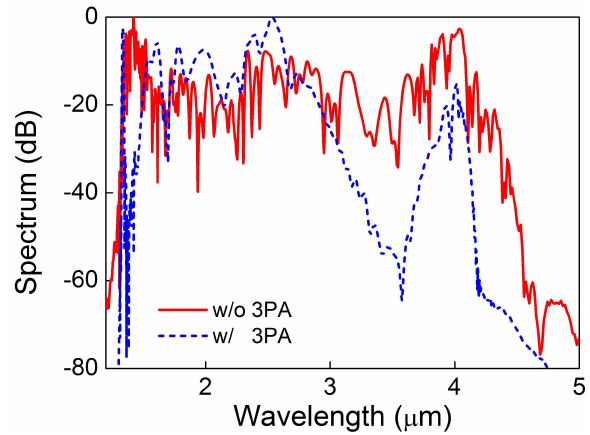
Figure 15: The spectral profiles of a single-pulse after propagation inside the 1 cm long SOI waveguide with (dashed line) and without (solid line) 3PA.